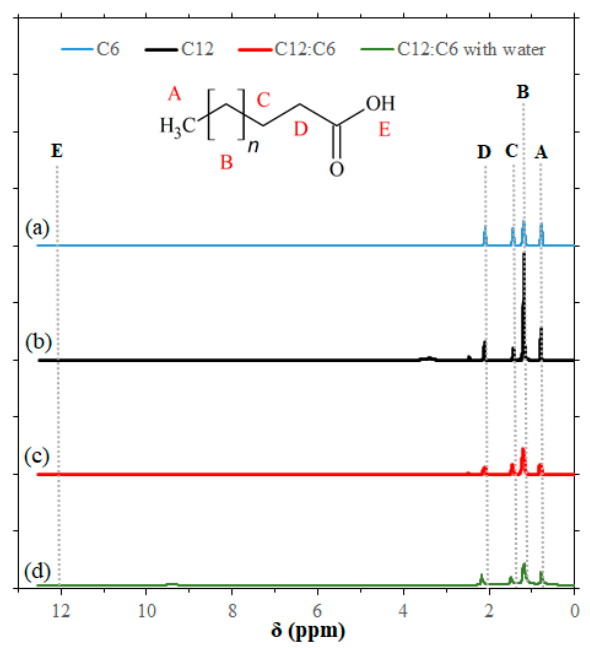
Figure 3. 1 H NMR spectra of the C12:C6 fatty-acid mixture prepared (red line) and its individual components, C12 (black line), and C6 (blue line). The 1 H NMR spectra of the C12:C6 mixture after mixing with water (green line) is also shown.